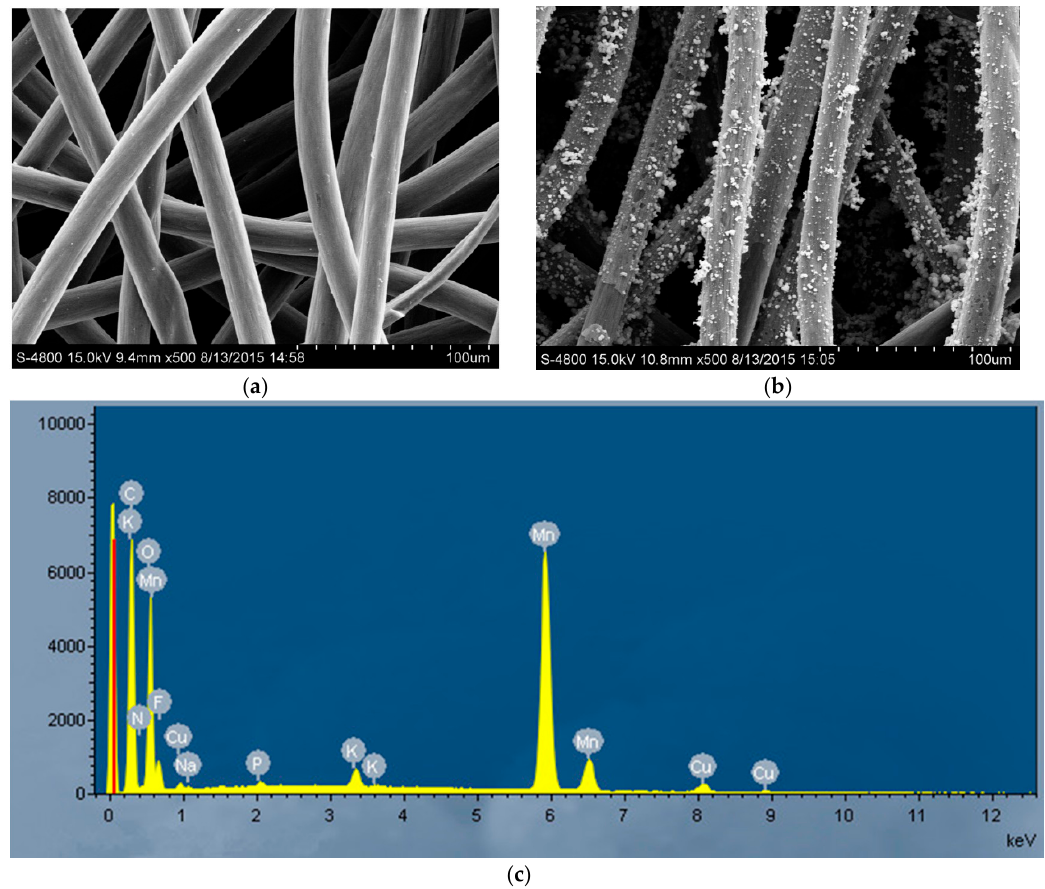
Figure 4. Scanning electron microscopy analysis. ( a ) Scanning electron microscopy picture of unmodified carbon felt; ( b ) Scanning electron microscopy picture of modified carbon felt; ( c ) Energy dispersive X-ray spectrum (EDS) of modified carbon felt.